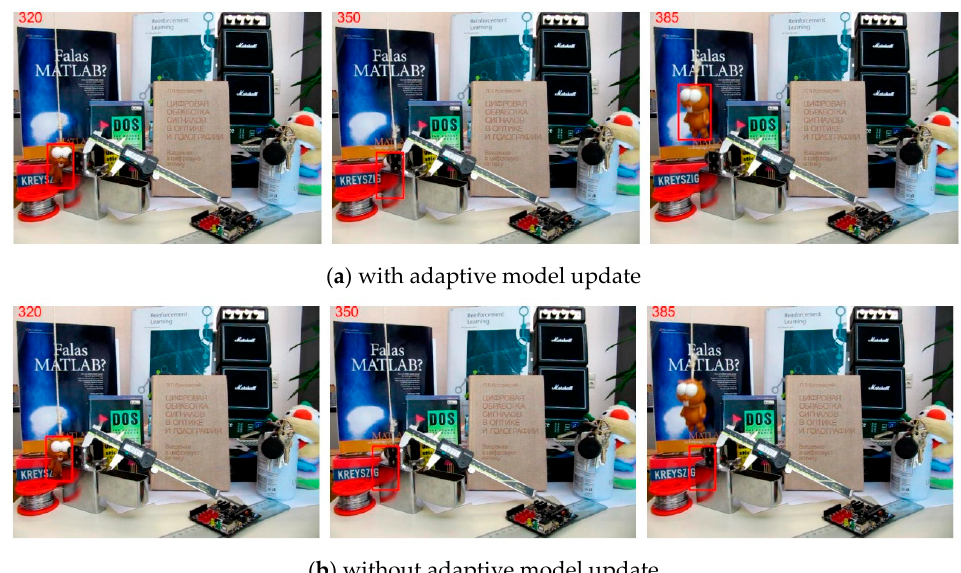
Figure 4. Tracking result of both trackers with or without adaptive model update.